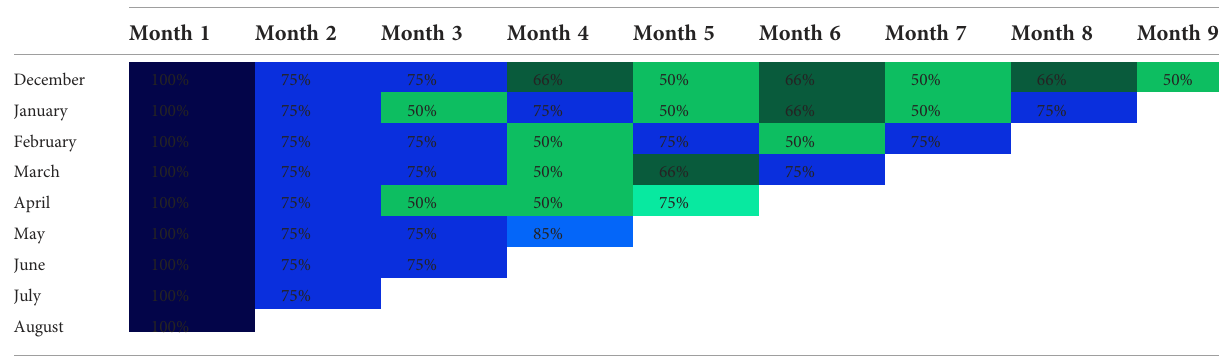
TABLE 4 App retention rate during the 9-month follow-up period.